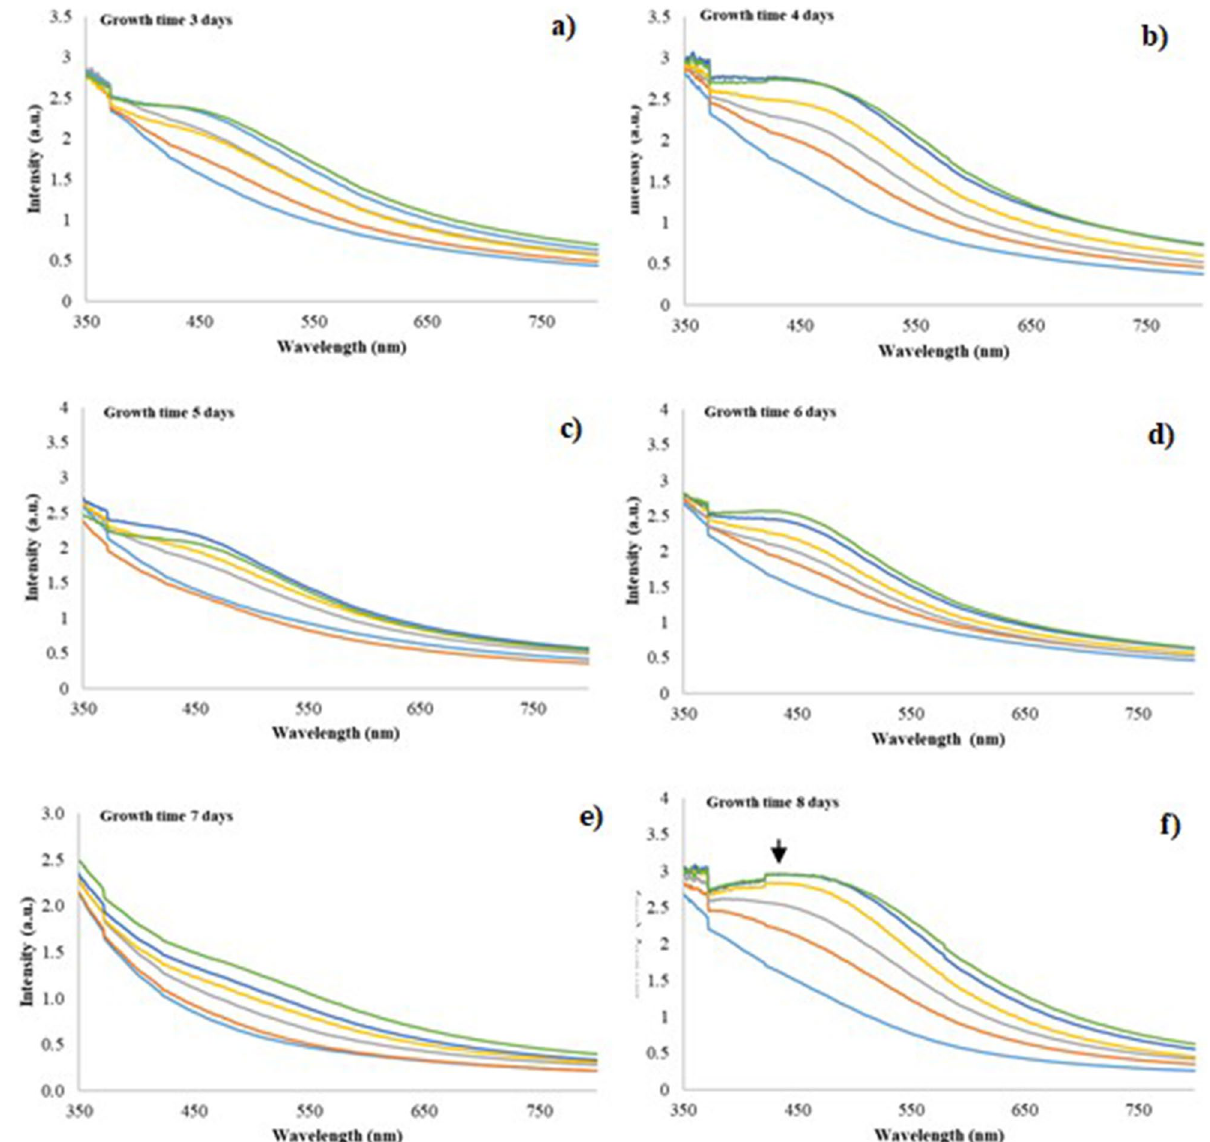
Figure 7. UV–Vis spectra for synthesized AgNPs using fungal filtrate from anamorphous Bjerkandera sp. R1 with a calculated error of: ( a ) Growth time 3 days (0.020–0.001); ( b ) Growth time 4 days (0.10–0.02); ( c ) Growth